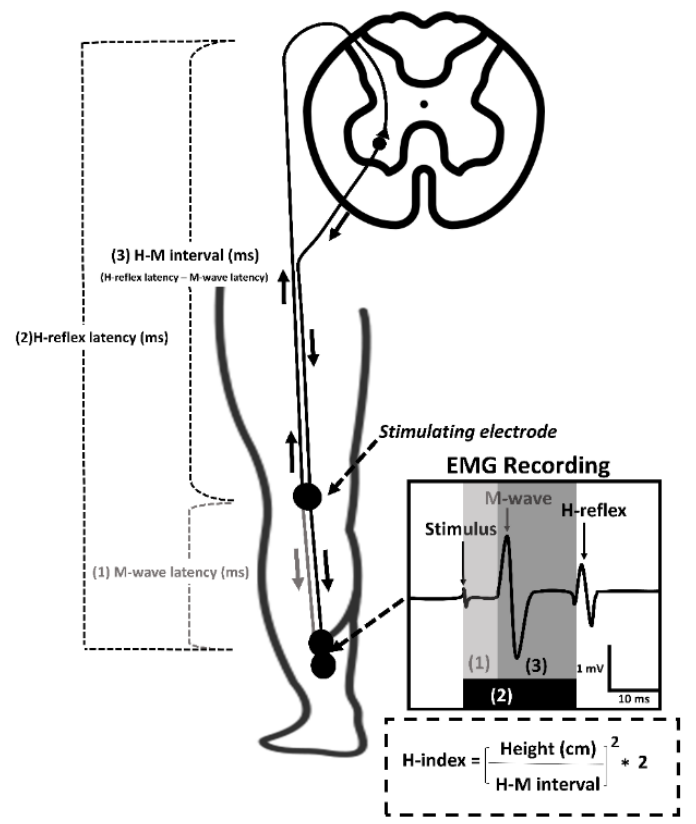
Figure 1. Analysis of H-index of lower leg muscles. ( 1 ) M-wave latency is a time delay between the stimulus artifact and the onset of the first wave (M-wave), reflecting the nerve conduction time of the direct efferent pathway. ( 2 ) H-reflex latency is a time delay between the stimulus artifact and the onset of the second wave (H-reflex), reflecting the nerve conduction time of both afferent and efferent pathways through the spinal reflex arc. ( 3 ) H-M interval is a time interval between the onset of M-wave and H-reflex, reflecting the conduction time of both afferent and efferent pathways, excluding the direct efferent pathway. A formula for H-index calculation provides normalization relative to participant height (dotted box, bottom right).